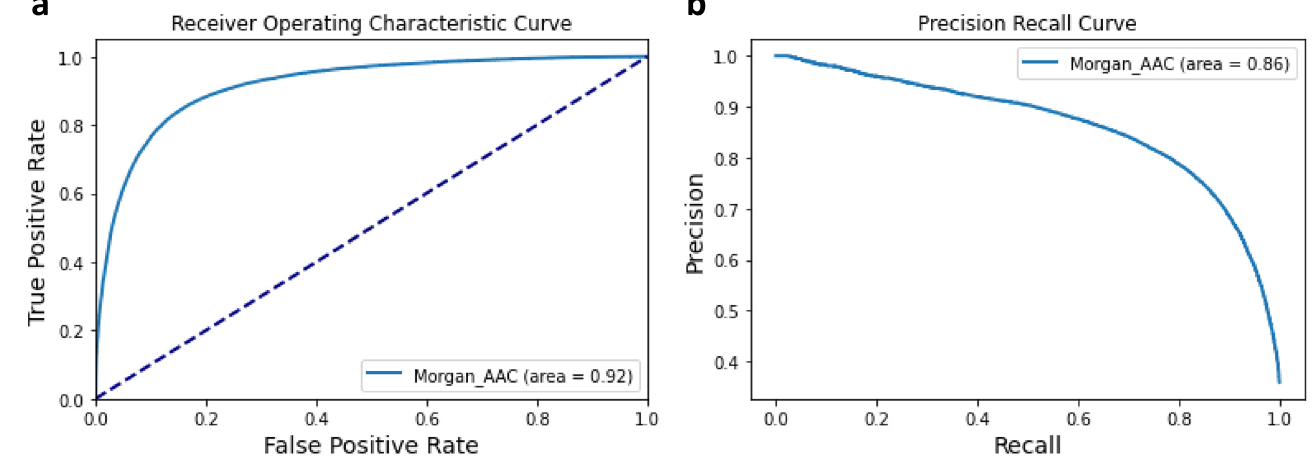
Figure 2. ( a ) ROC curve (Morgan + AAC) based on the test BindingDB datasets ( b ) Precision-Recall curve (Morgan + AAC) on test datasets.